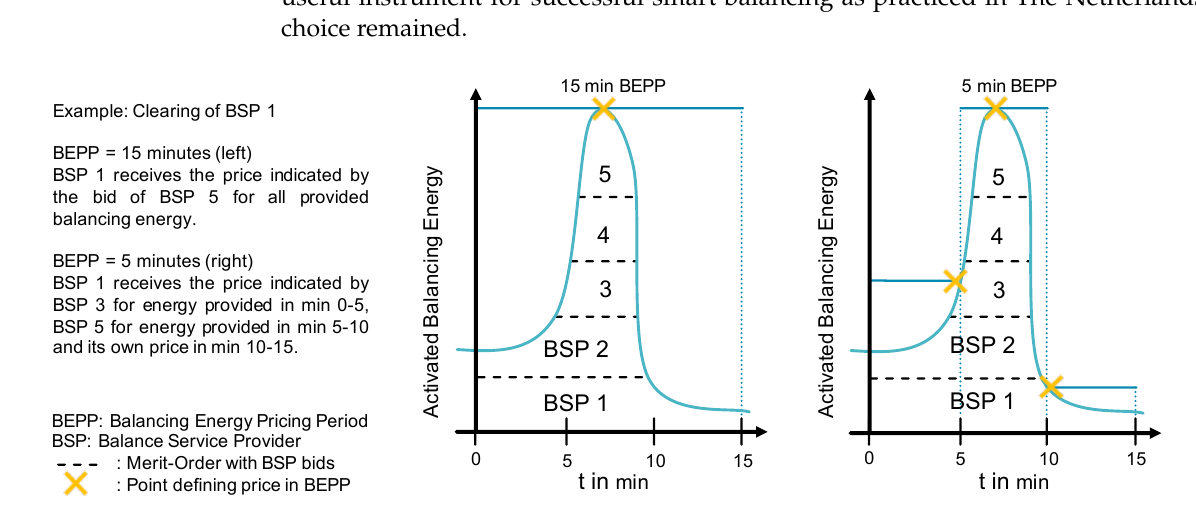
Figure 4. Example with marginal clearing of balancing energy: BEPP 15 min vs. BEPP 5